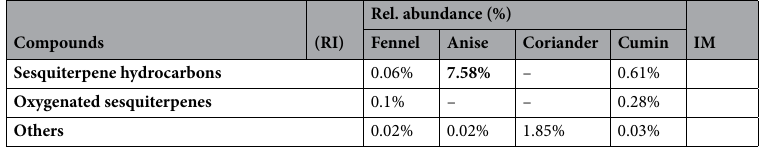
Table 1. Volatile oil constituents identified in the essential oils of fennel, anise, coriander, and cumin fruits were analyzed by GC–MS. Significant values are in bold.